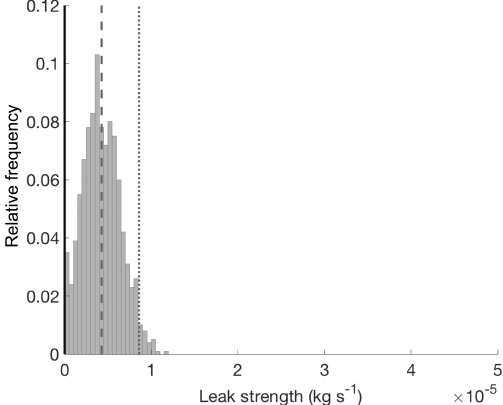
Figure 11. Histogram of NZMB estimated source strength at source location 1, with dashed line showing the bootstrap mean and thin dotted lines showing ± 2 standard deviation. The thick black line shows the true leak strength at source location 1 (3.1 × 10 − 5 kgs − 1 ) .